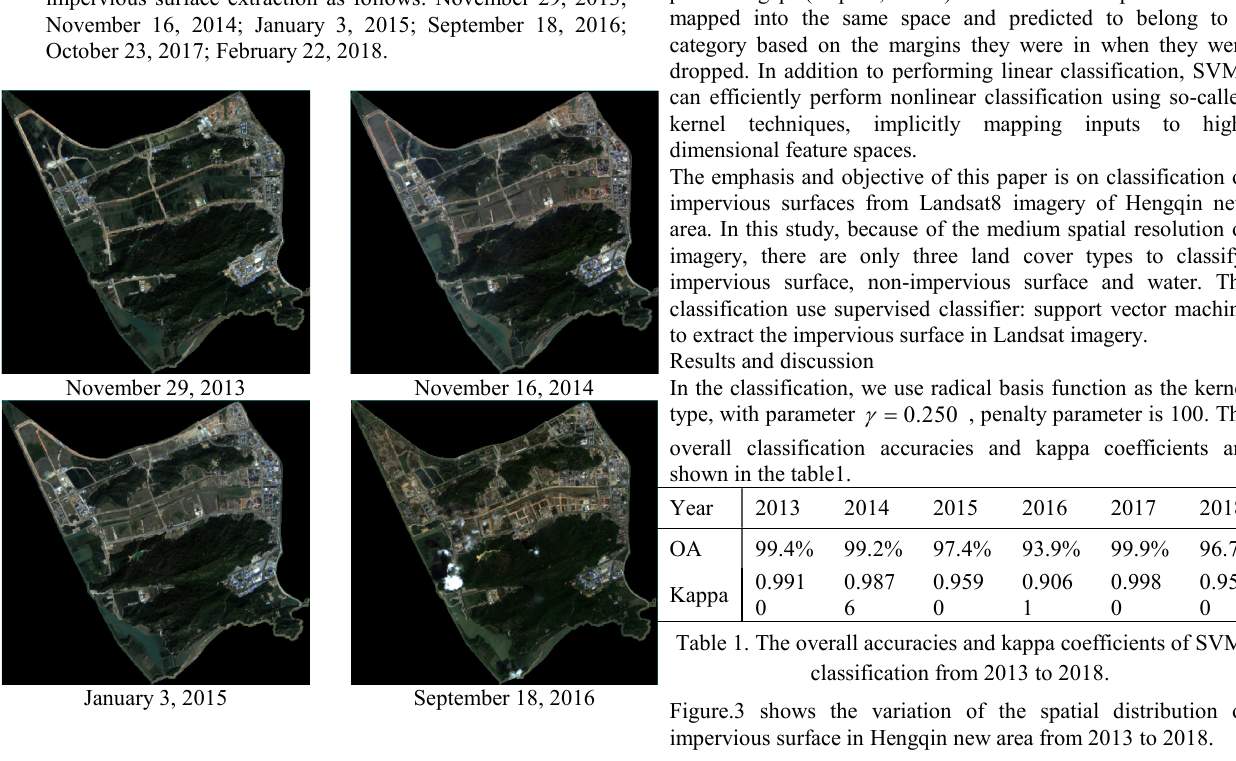
Figure 1. Landsat image of Hengqin area The imagery are acquired from USGS Earth Explorer for impervious surface extraction as follows: November 29, 2013;